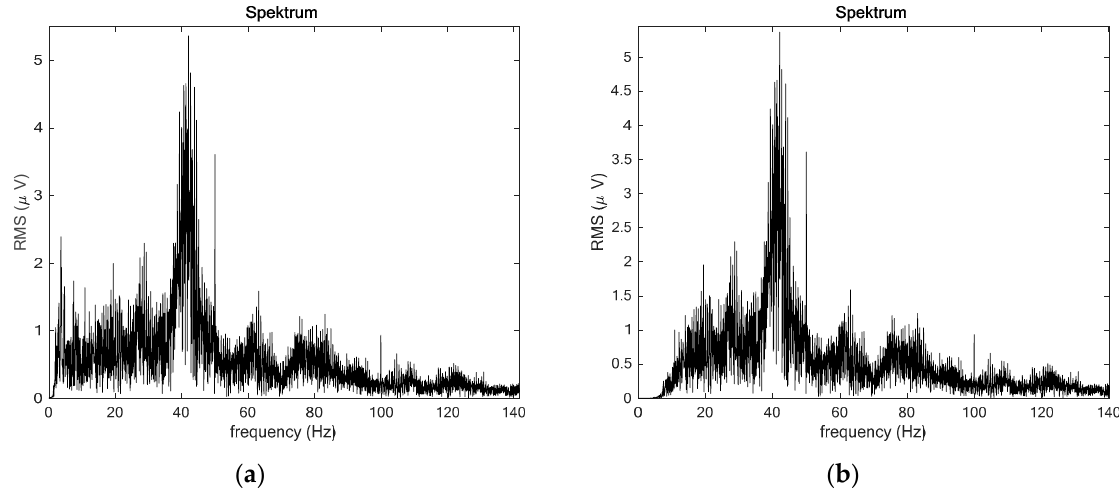
Figure 10. Zoom spectrum of EMG signal for right abdominal muscle after HP filtering using 3rd order Butterworth HP filter, ( a ) for f c = 2 Hz, ( b ) for f c = 10 Hz